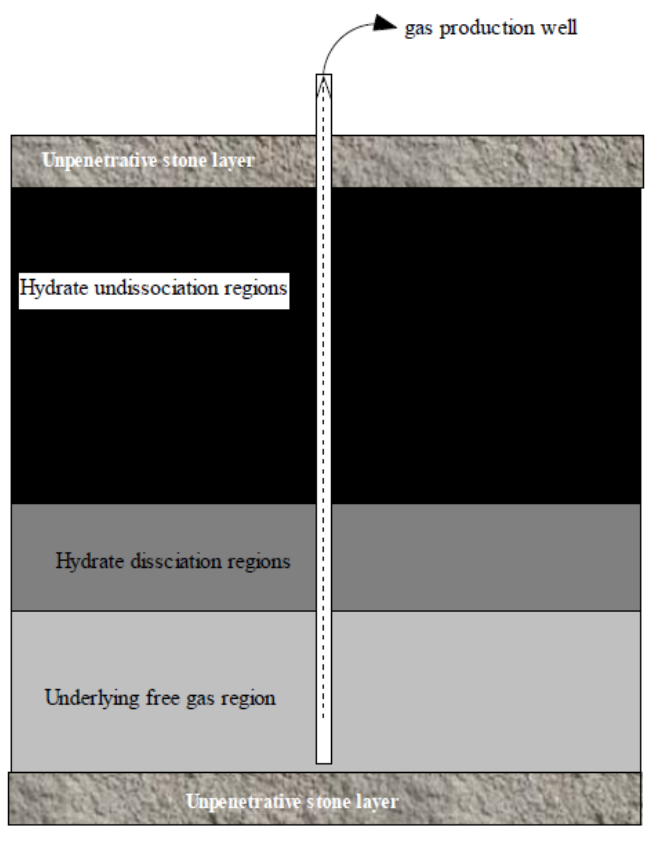
Figure 2. Gas production from hydrates by the depressurization